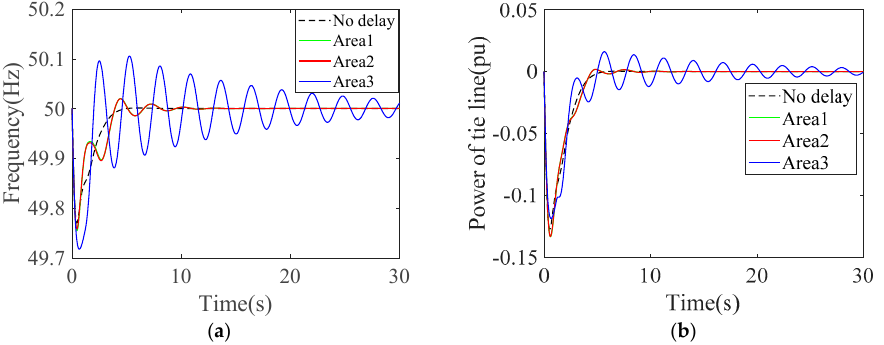
Table 2. Model parameters of the three-area system.